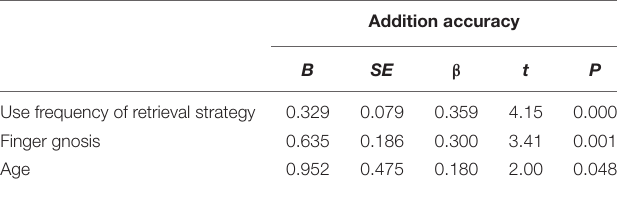
TABLE 3 | Regression model predicting addition